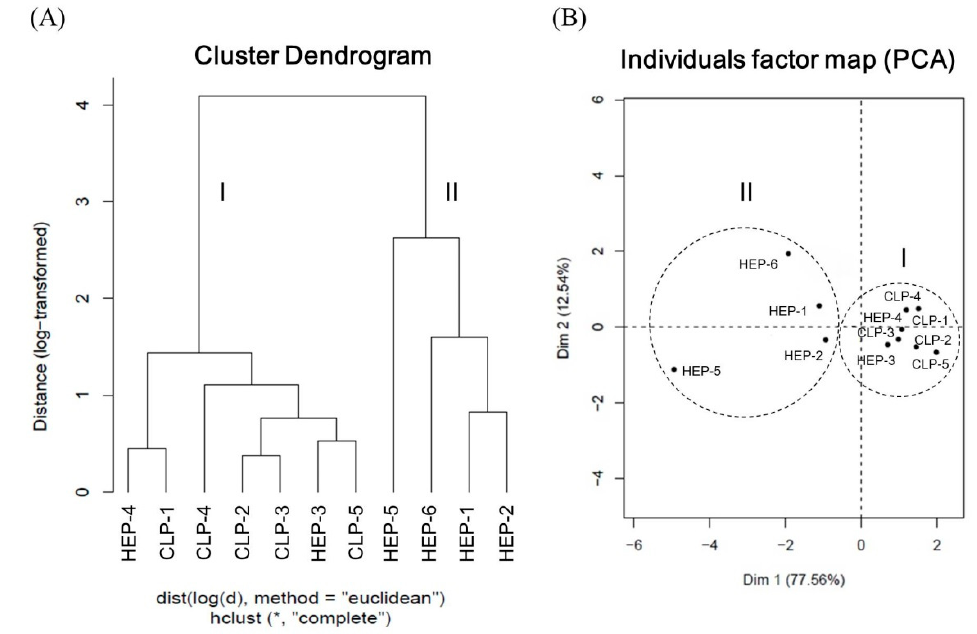
Figure 2. ( A ) Dendrogram of hierarchical cluster analysis and ( B ) score plot of principal component analysis for the 11 samples of lotus plumule products in Taiwan. HEP: Herbal extract product; CLP: Crude lotus plumule.